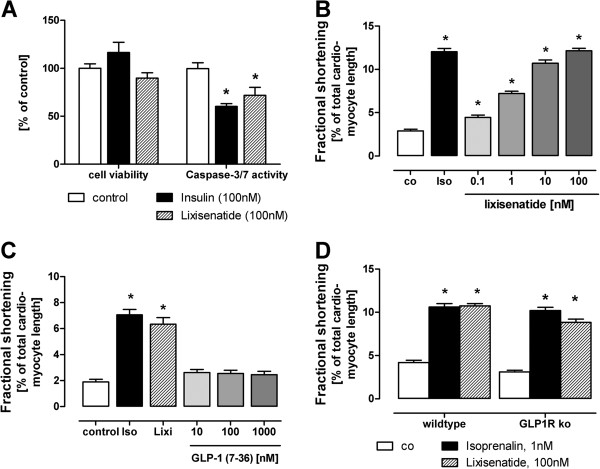
Effect of lixisenatide treatment on apoptosis and contractility of isolated cardiomyocytes. (A) Caspase-3/7 activity is reduced in cardiomyocytes incubated with either insulin or lixisenatide (each at 100 nM). (B, C) Lixisenatide (Lixi) but not GLP-1 (6–36)-amide increases fractional shortening. Isoprenaline (Iso, 1nM) served as positive control. (D). Cardiomyocytes isolated from GLP-1 receptor knockout mice respond to lixisenatide. Mean values and SEM are given. In the fractional shortening experiments, n > 18 single cardiomyocytes were measured for each group.